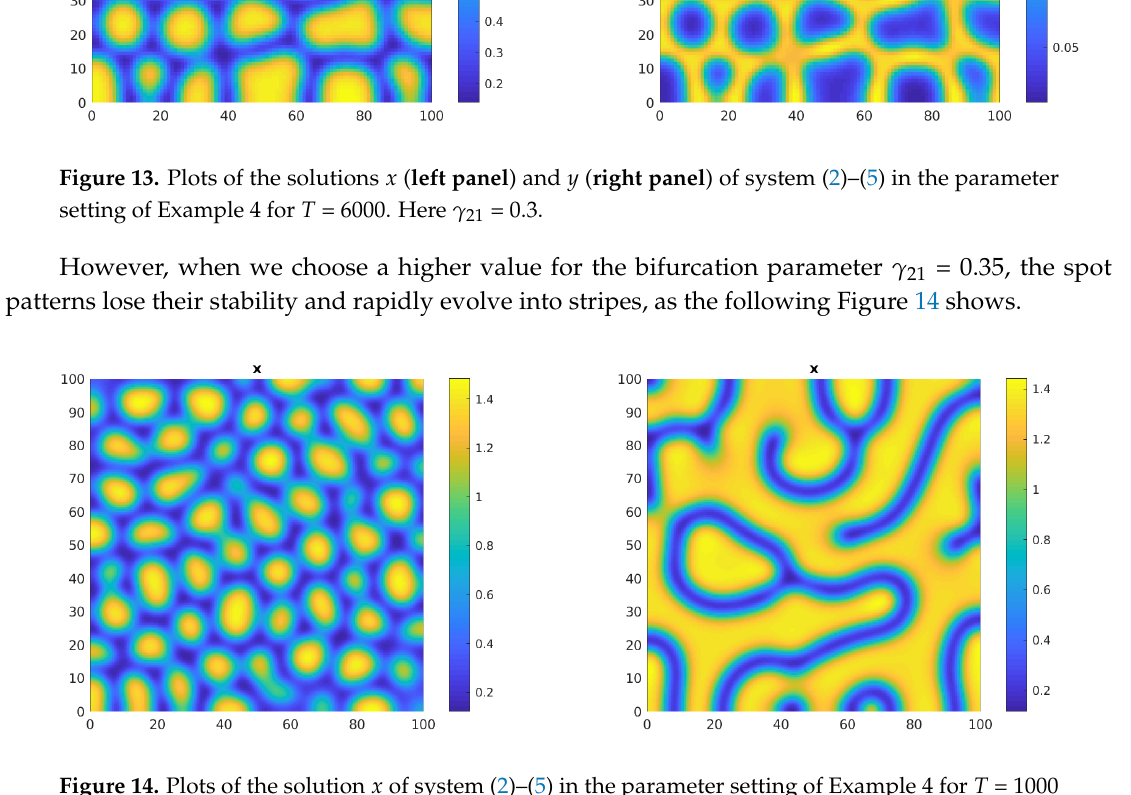
Figure 14. Plots of the solution x of system (2)–(5) in the parameter setting of Example 4 for T = 1000 and T = 2000. Patterns for the y solution (not shown) are complementary to these ones. Here γ 21 =